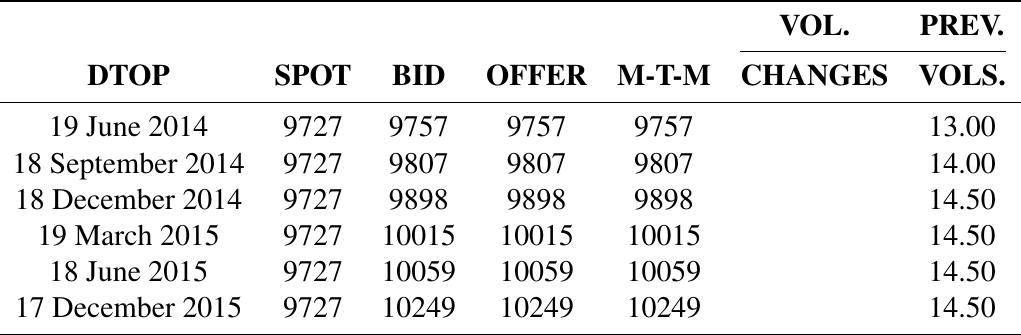
Table 5. DTOP mark-to-market (MtM) data on 28 May